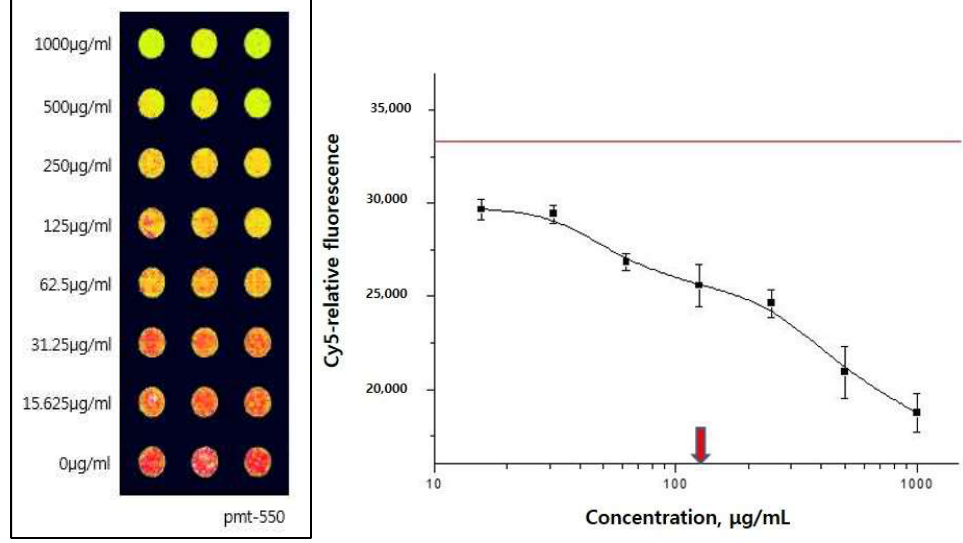
Figure 2. Dose-response curve and half-maximal inhibitory concentration (IC50) of YmP in the 5- HT2C receptor binding assay. When YmP was added to 5-HT2c receptors dose-dependently, the IC50 value of YmP was 199.9 µg/mL. Concentration of 5-HT2cR is 50 μ g/mL and concentration of Cy5-labeled Tryptamine is 500 μ M. Modified Yukmijihwang-tang (YmP); photomultiplier tubes (pmt).